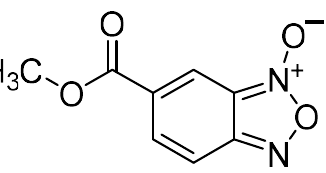
Figure 2. Chemical structure of QX5 (benzofuroxan methyl-5-carboxylate N-oxide).